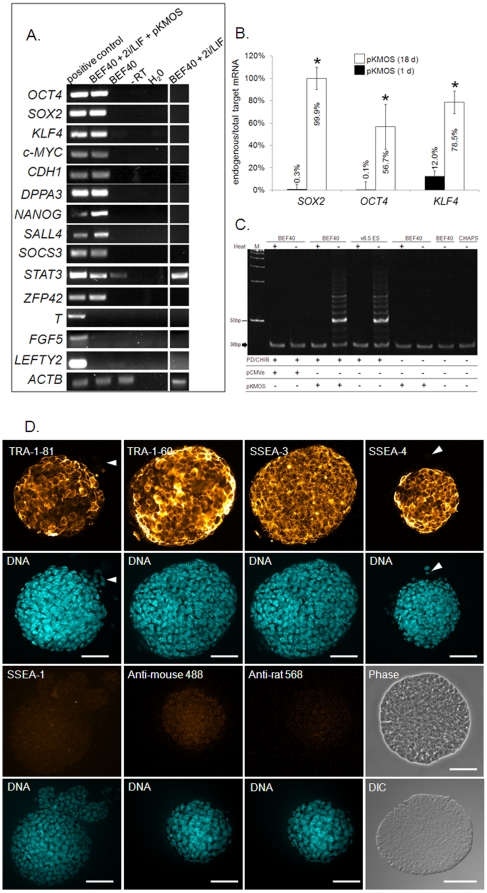
Molecular characterization of bovine iPSC-like colonies.(A) RT-PCR analysis. cDNA was extracted from 10 colonies/pool, cDNA from 10 bovine blastocysts/pool (bovine D16 epiblasts and MII oocytes for T-BRACHYURY and FGF5, respectively) provides a positive control. (B) qRT-PCR of endogenous vs total target gene expression in cells vs colonies (1 d vs 18 d post-transfection, respectively); target genes values were normalized on 18S expression. * =  values differ P<0.05 between time points; (C) Telomerase activity using the TRAP assay. Heat-inactivated (+) samples and CHAPS buffer serve as negative, mouse ESCs (v6.5) and 36 bp internal control band (arrow) as positive controls. (D) Confocal immunofluorescence. DNA was counterstained with Hoechst 33342. Arrowheads indicate negative cells. Stainings without primary antibodies (anti-mouse 488 and anti-rat 568) provide negative controls. Phase  =  phase contrast, DIC  =  Differential interference contrast. Scale bar  = 50 µm.